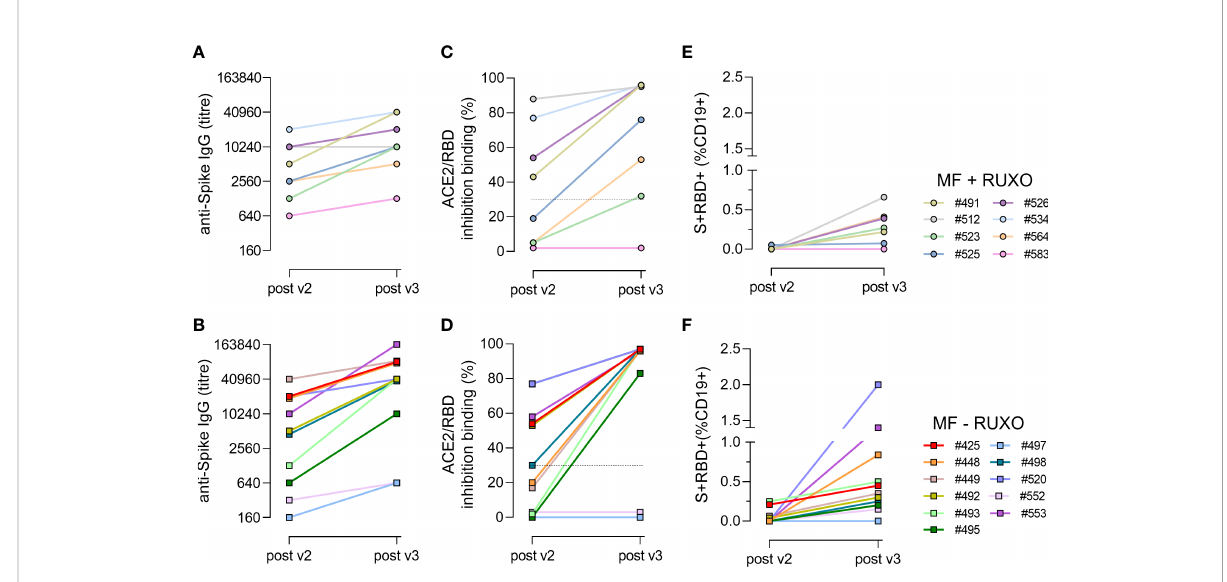
FIGURE 4 Time course of spike-speci fi c antibody and B cell responses in plasma of myelo fi brosis (MF) patients after the second and third SARS-CoV-2 mRNA vaccine dose. Nineteen MF patients, 8 with ruxolitinib (Ruxo) treatment (A, C, E) and 11 without therapy (B, D, F) , were monitored after two (post v2) and three (post v3) doses of mRNA SARS-CoV-2 vaccine to study the kinetic of spike-speci fi c IgG (A, B) , the ACE2/RBD binding inhibition activity (C, D) and the spike/ + RBD + -speci fi c B cells generated (E, F) . Each subject is identi fi ed with a number and a color, as reported in the